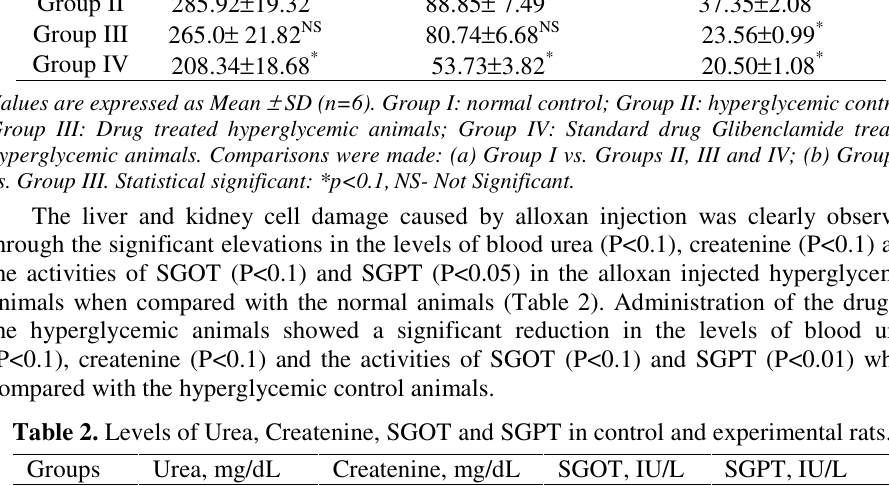
Table 1. Levels of glucose, total cholesterol and triglycerides in control and experimental rats. Groups Glucose, mg/dL Total Cholesterol, mg/dL Triglycerides, mg/dL Group I 92.03 ± 8.02 64.18 ± 4.38